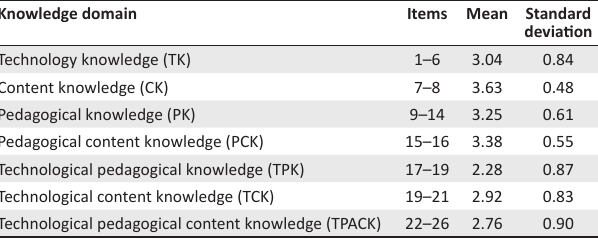
TABLE 4: Mean and standard deviation for each of the seven knowledge domains included in the TPACK framework.